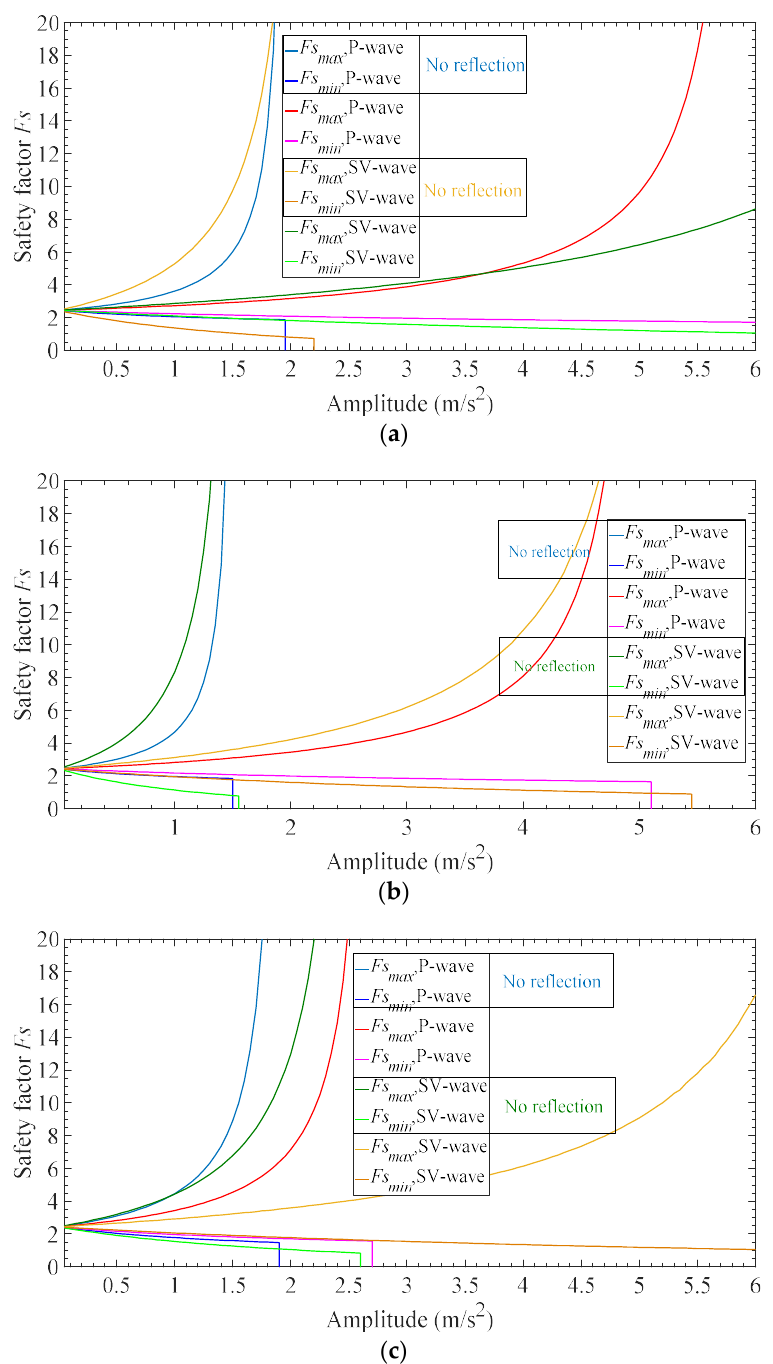
Figure 12. Comparison of free slope surface with reflection and no reflection (instantaneous safety factor vs. wave amplitude): ( a ) model I; ( b ) model II; ( c ) model III.